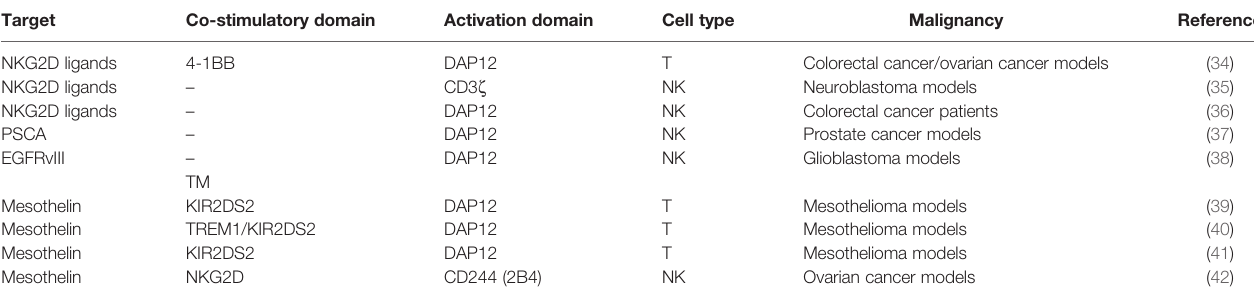
TABLE 1 | CARs modi fi ed by NK cell receptors in solid